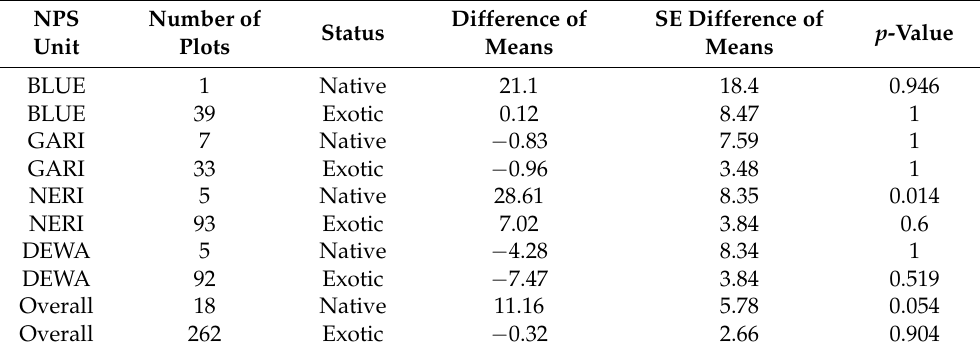
Table A7. Tukey method comparison for differences of means (disturbed–undisturbed) for change in plant cover (%) between disturbed and undisturbed plots for each NPS unit and for all the units combined following the disturbance events.